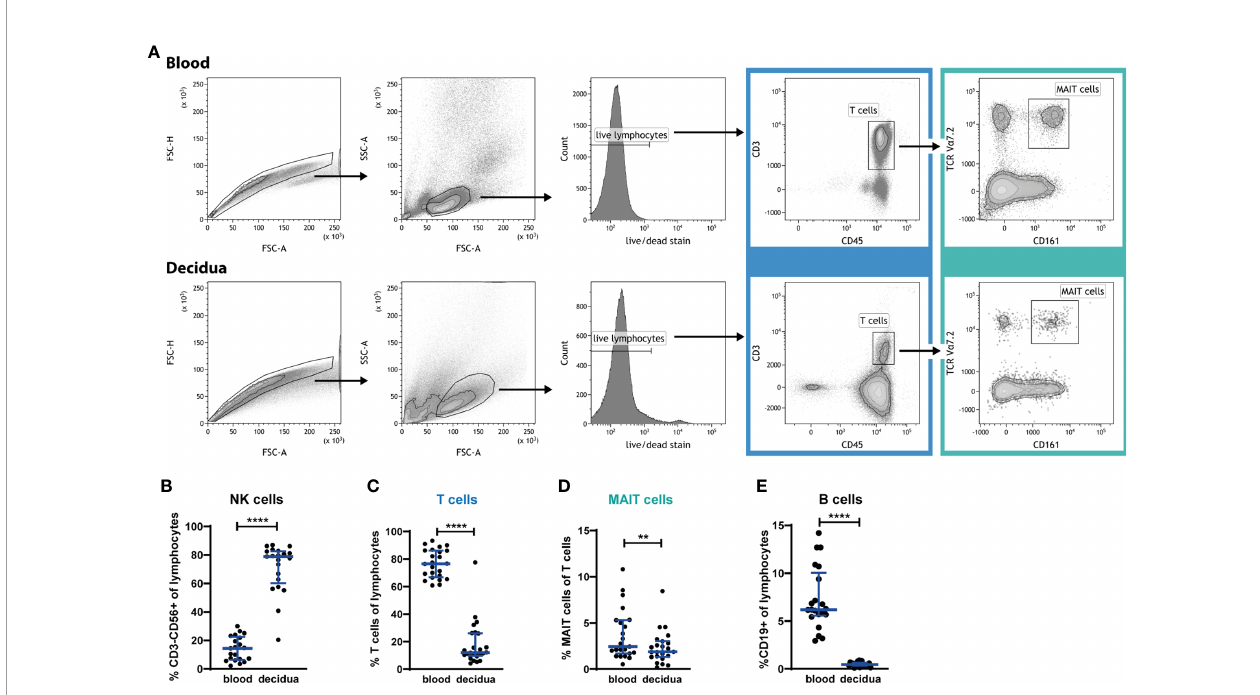
FIGURE 1 | MAIT cells are present in 1 st trimester decidua, but are relatively excluded from the decidua. (A) Gating strategy for circulating (blood) and decidual T cells and MAIT cells. PBMCs and decidual cells were isolated from 1 st trimester blood and decidual tissue, respectively, from the same donors, and analyzed by fl ow cytometry. MAIT cells are identi fi ed by their expression of CD45, CD3, V a 7.2 and CD161. (B) NK cell, (C) T cell, (D) MAIT cell, and (E) B cell frequency in PBMCs (blood) and in cells isolated from decidua, expressed as percent of CD45 + lymphocytes, or – in the case of MAIT cells – expressed as percent of T cells. Gating strategies for NK and B cells are presented in Supplementary Figure S2 . Bars depict median and interquartile range (IQR) from 21 donors in (B, E) , 24 donors in (C) and 23 donors in (D) . Statistical comparisons were performed with Wilcoxon signed-rank test. ** p < 0.01, **** p <